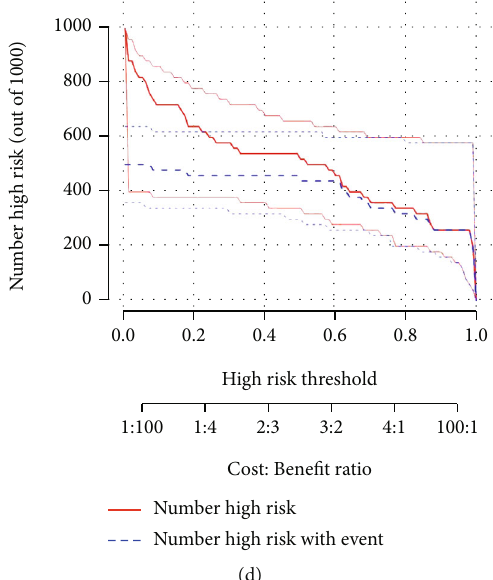
Figure 4: (a) A nomogram on the basis of six candidate IRGs was developed to predict the prevalence of IDD in patients. (b) We con fi rm that the nomogram predictions are accurate by the results of the calibration curve. (c) The DCA curve suggests that decision-making on the basis of the nomogram may bene fi t patients with IDD because the red lines are consistently maintained above the gray and black lines of 0 to 1. (d) The signi fi cant predictive ability of the nomogram was demonstrated by the clinical impact